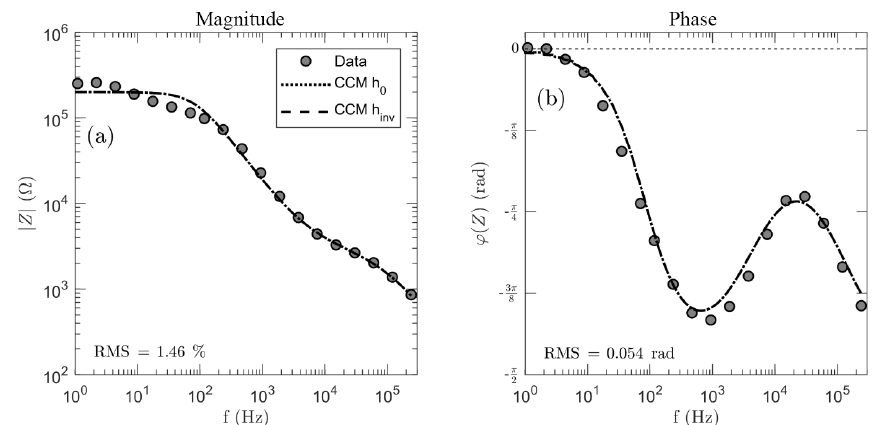
Figure 4. Spectra for the magnitude (a) and the phase shift (b) of the impedance for measured data (dots) and inversion results by using the Cole–Cole model (CCM, lines). The inversion was carried out twice, with the assumption of zero electrode height ( h 0 ) and by calculating the height as an additional inversion parameter ( h inv ). The simulated curves of the two inversions can not be distinguished from each other. Data were measured at profile B-SCH, Schilthorn area, Switzerland, in a dipole-dipole configuration ( a = 1 m , n = 1). The CCM parameters are ( h 0 and h inv ): ρ DC = 3 . 8 × 10 6 (cid:127) m, ε DC = 53, ε HF = 2 . 8, τ = 3 . 6 × 10 − 5 s, c = 0 .